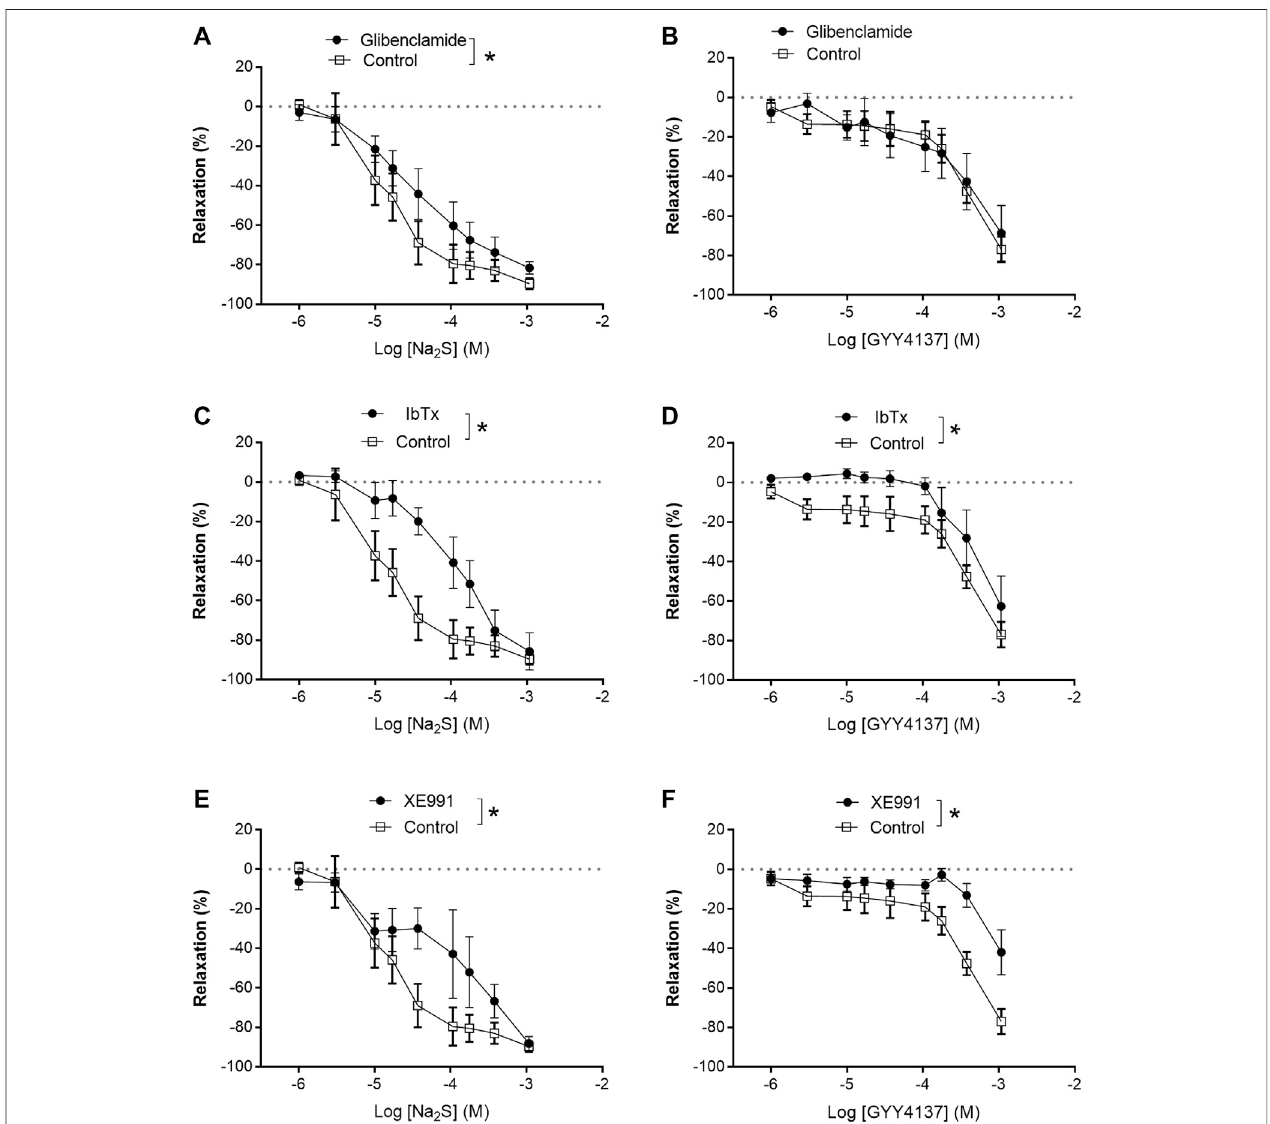
FIGURE 8 | Effect of K channels blockers on Na 2 S and GYY4137 relaxation. (A) Effect of inhibition of K ATP channels by glibenclamide (1 µM) on Na 2 S-induced vascular relaxation; (B) effect ofinhibition ofK ATP channels by glibenclamideon GYY4137-induced vascular relaxation; (C) effect ofselective blockade ofBK Ca channels by iberiotoxin (IBTX, 100 nM) onNa 2 S-induced vascular relaxation; (D) effectofselective blockade of BK Ca channels byIBTX on GYY 4137-induced vascular relaxation; (E) effect of selective blockade of Kv7 channels by XE991 (10 µM) on Na 2 S-induced vascular relaxation; (F) effect of selective blockade of K V 7 by XE991 on GYY4137-induced vascular relaxation. Where no error bars are indicated, errors lies within dimensions of symbol. All data are means ± SEM ( n (cid:2) 8 – 10). * p < 0.05, two- way ANOVA.